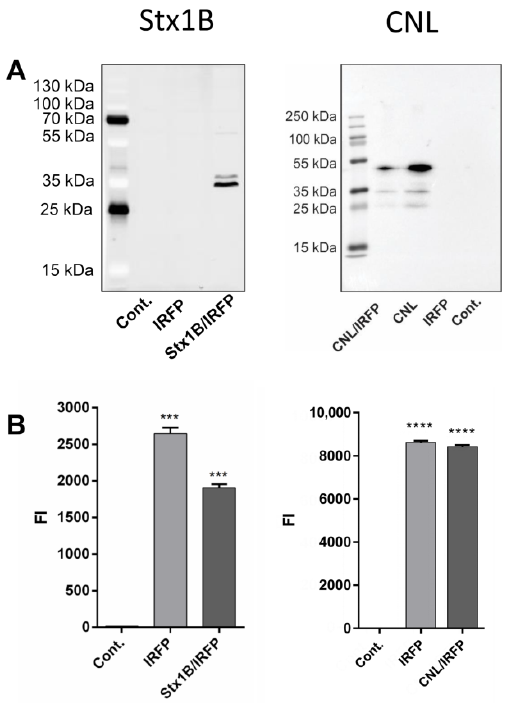
Figure 5. Expression of lectin fusion proteins and infrared fluorescent protein (IRFP) in L. lactis. Shiga holotoxin subunit B (Stx1B; left) and Clitocybe nebularis lectin (CNL; right) in fusion with Usp45 secretion signal and cAcmA anchoring domain were detected in the cell lysate of L. lactis by western blot with the anti-FLAG-tag and anti-CNL antibodies, respectively ( A ). The concomitant expression of infrared fluorescent protein (IRFP) was demonstrated by fluorescence intensity (FI) measurements ( B ). Cont.: control containing empty plasmid pNZ8148. Error bars denote standard deviations. Significant differences were determined by the Student’s t-test (*** p < 0.001, **** p < 0.0001).